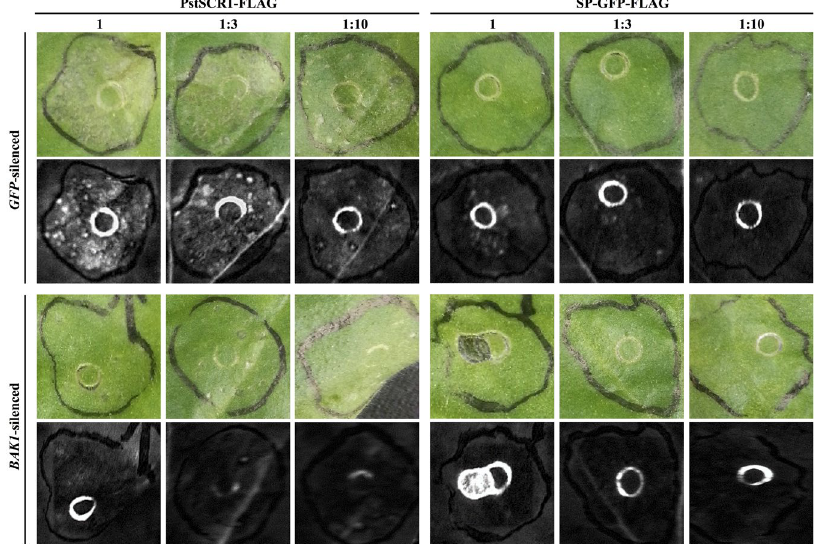
Figure 5. NbBAK1 is required for PstSCR1 triggered cell death. Apoplastic fluid from plant samples expressing PstSCR1-FLAG and SP-GFP-FLAG were infiltrated into NbBAK1 and GFP silenced N . benthamiana with varying amounts; 1 ((no dilution), 1:3 and 1:10) dilutions. Following 4-d after apoplastic fluid infiltration, the leaves were examined under normal light and UV